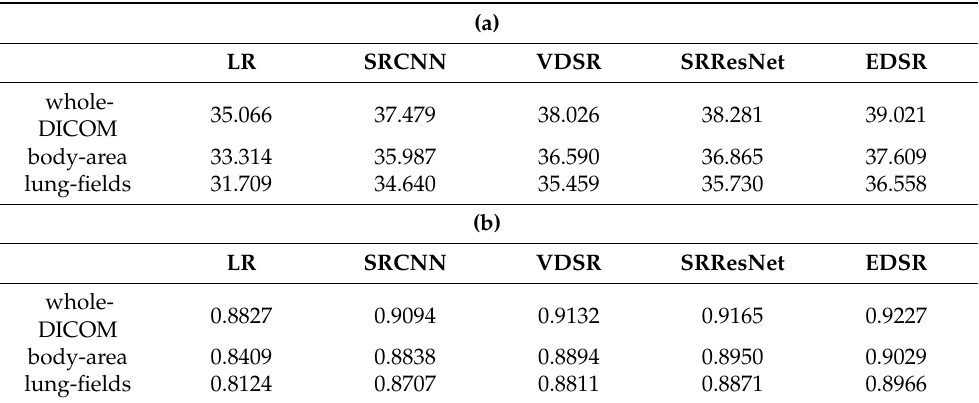
Table 7. Mean image quality metrics of different ROIs in SR images compared to the ground-truth HR images. ( a ) Mean PSNR of different ROIs in SR models. ( b ) Mean SSIM of different ROIs in SR models.